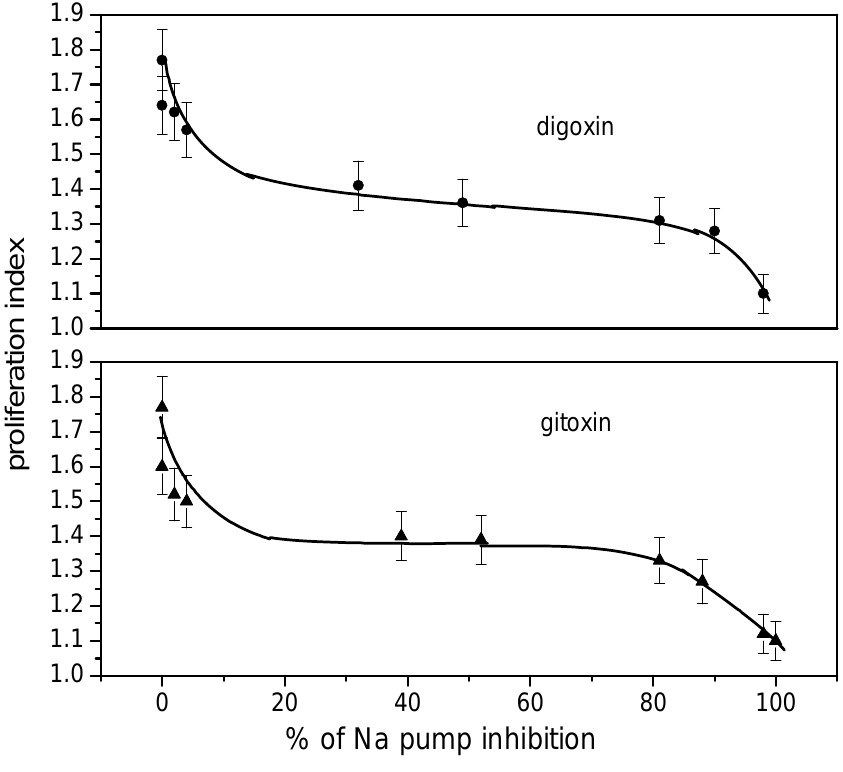
Figure 4 . Dependence of proliferation index in harvested human lymphocytes exerted to digoxin and gitoxin on % Na + ,K + -ATPase